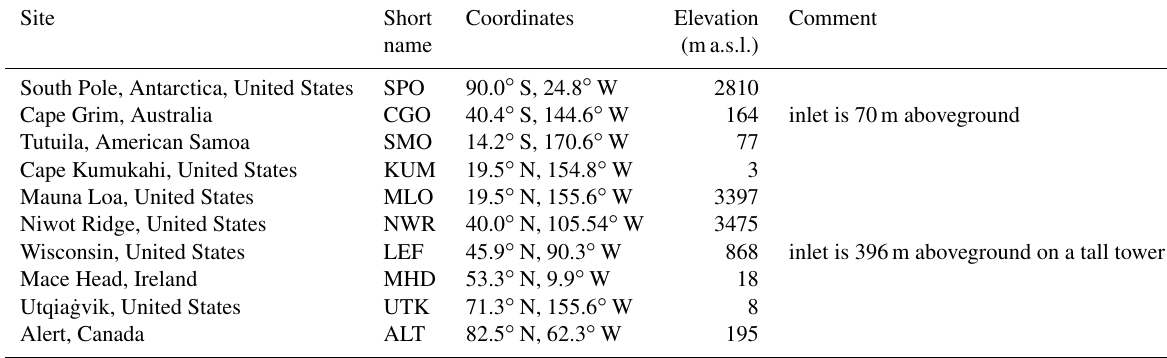
Table 4. List of air sampling sites selected for evaluation of COS and CO 2 concentrations. Site Short Coordinates Elevation Comment name (ma.s.l.) South Pole, Antarctica, United States